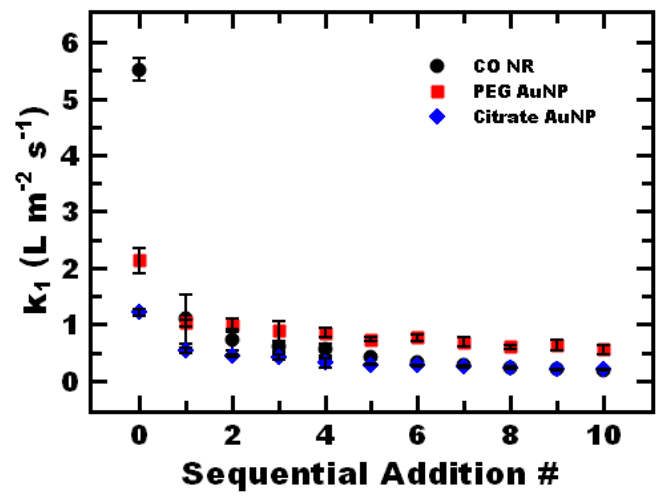
Figure 3. Sequential additions of 4-nitrophenol performed with PEG-stabilized gold nanoparticles (PEG AuNP) (red), CO NR (black), compared to citrate-stabilized gold nanoparticles (citrate AuNP) (blue) with 1-M NaBH 4 .